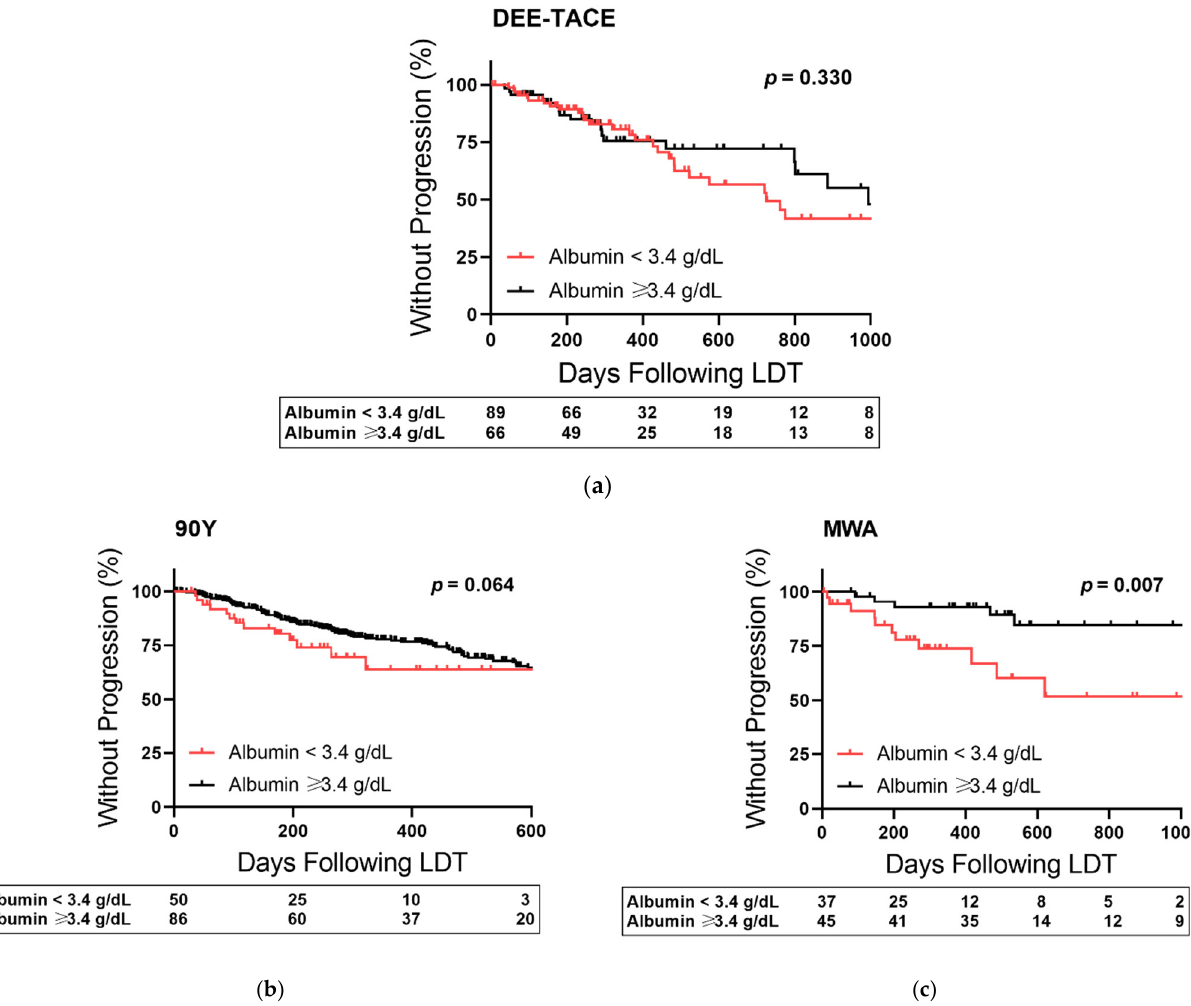
Figure 6. Albumin-Stratified Kaplan–Meier Curves of Time to Progression in Optimal Bridge to Liver transplant (LT) Patients. Plot restricted to patients with burden at diagnosis defined as T1 and within Milan Criteria, with Barcelona Clinic Liver Cancer (BCLC) Stage A disease, and having a baseline alpha-fetoprotein (AFP) < 20 ng/mL. Censored data is marked with a vertical upward dash. The total number of patients remaining in the analysis at each major x-axis time point is listed in the table below the plot. Significance was determined using the Log-Rank test.